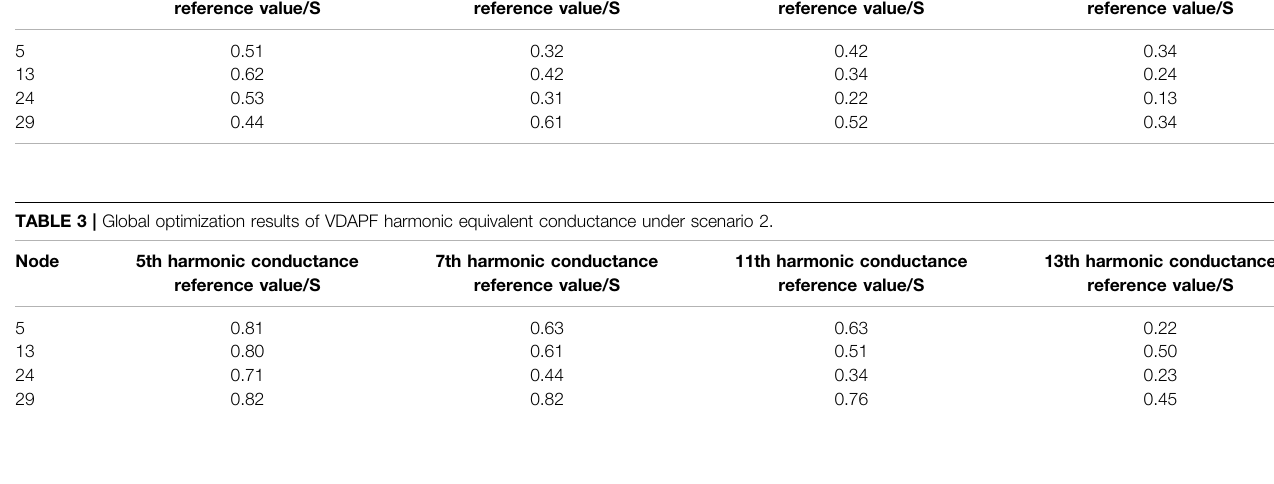
TABLE 2 | Global optimization results of VDAPF harmonic equivalent conductance under scenario 1. Node